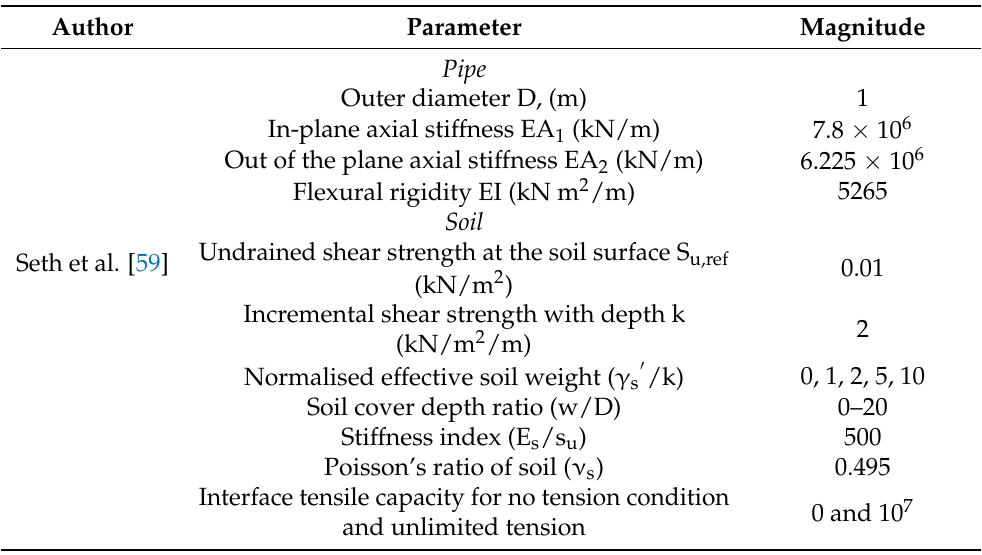
Figure 15. Influence of soil cover depth and soil unit weight on lateral capacity factor of an offshore pipeline under NT and FT condition [59]. Table 4. Parameter used in the Numerical models for lateral resistance of buried